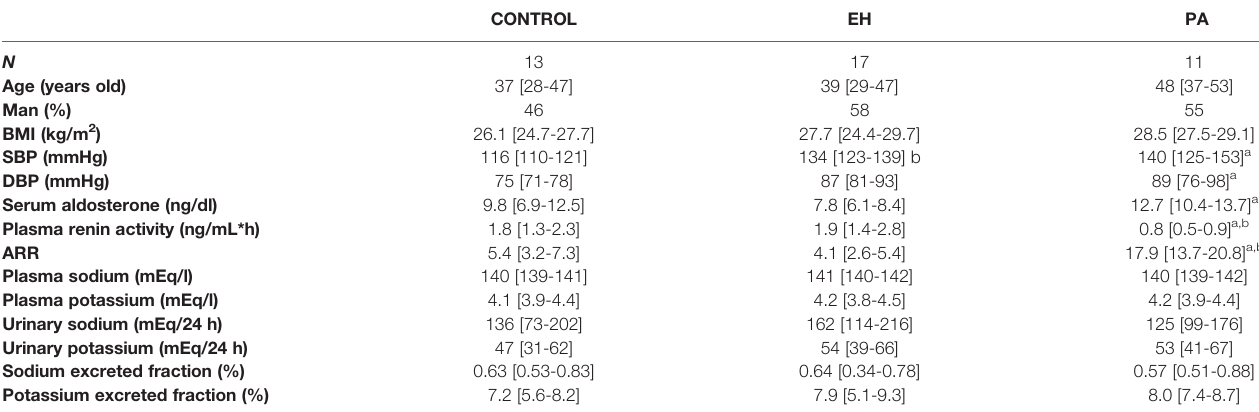
TABLE 1 | Clinical and biochemical parameters of subjects identi fi ed as control, EH, and primary aldosteronism.